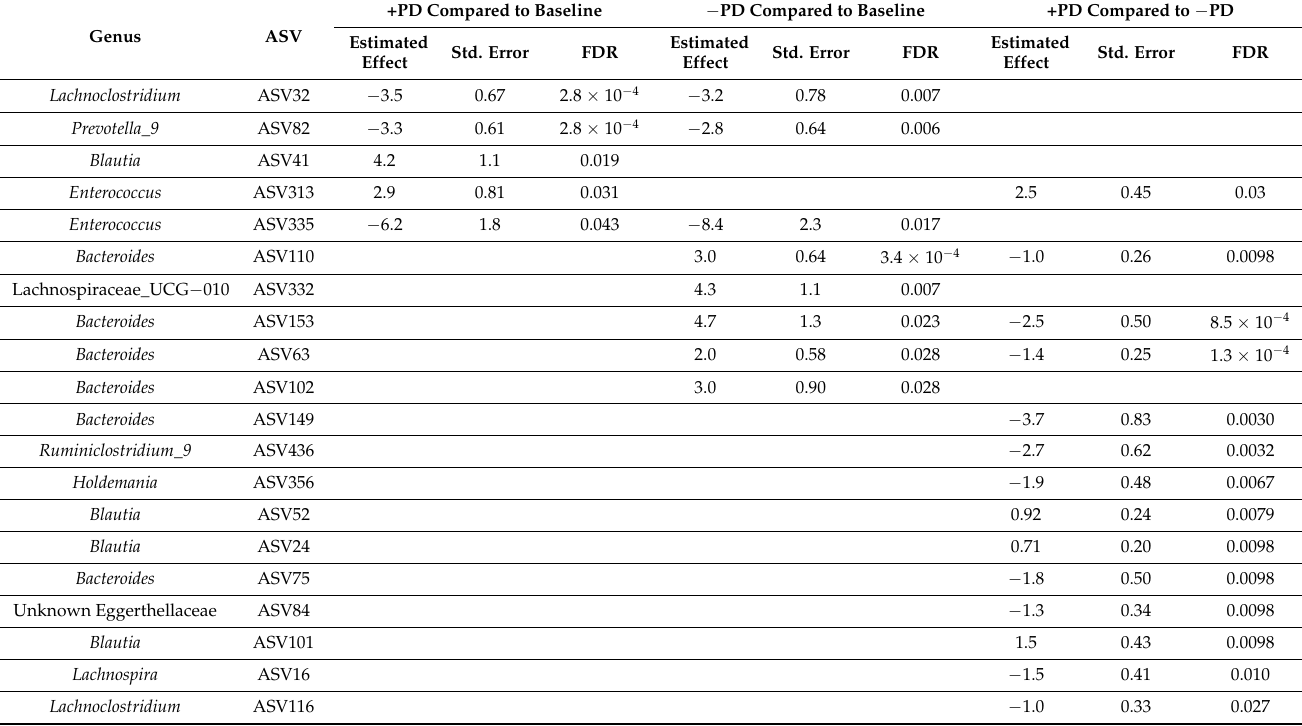
Table 2. Effect of diets on relative bacterial abundance in faecal